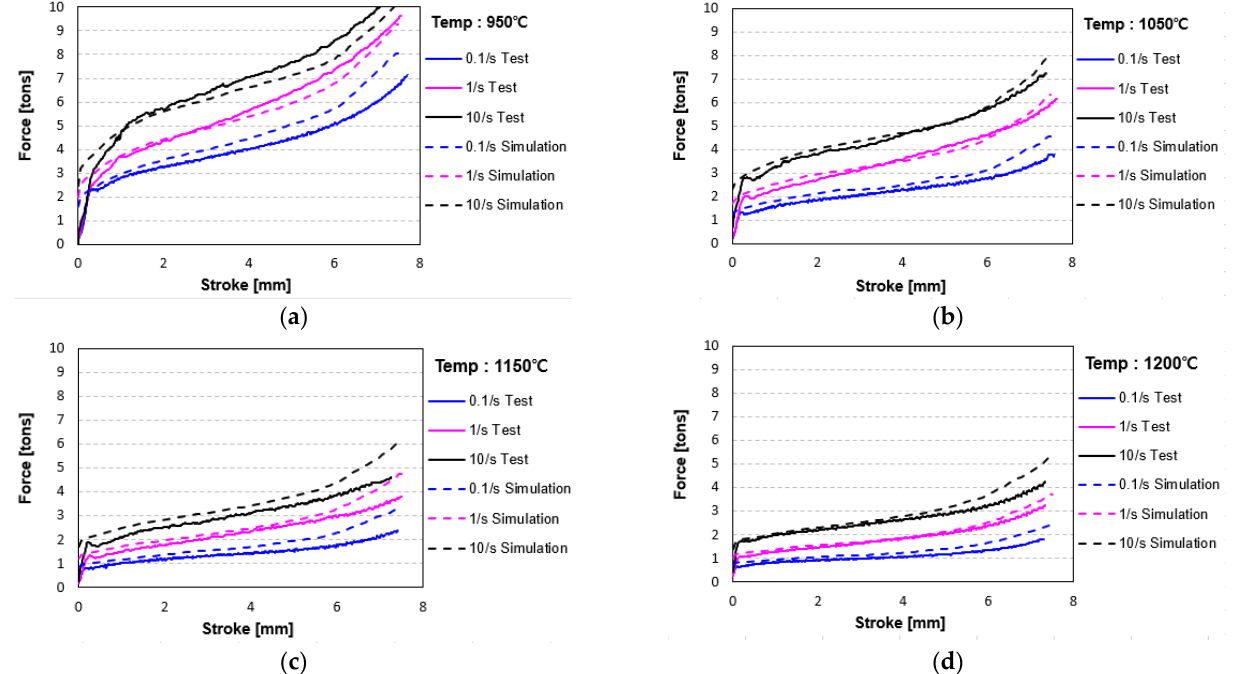
Figure 8. Comparison of experimental and simulated stroke – force curves without optimization: ( a ) 950 °C, ( b ) 1050 °C, ( c ) 1150 °C, ( d ) 1200 °C.